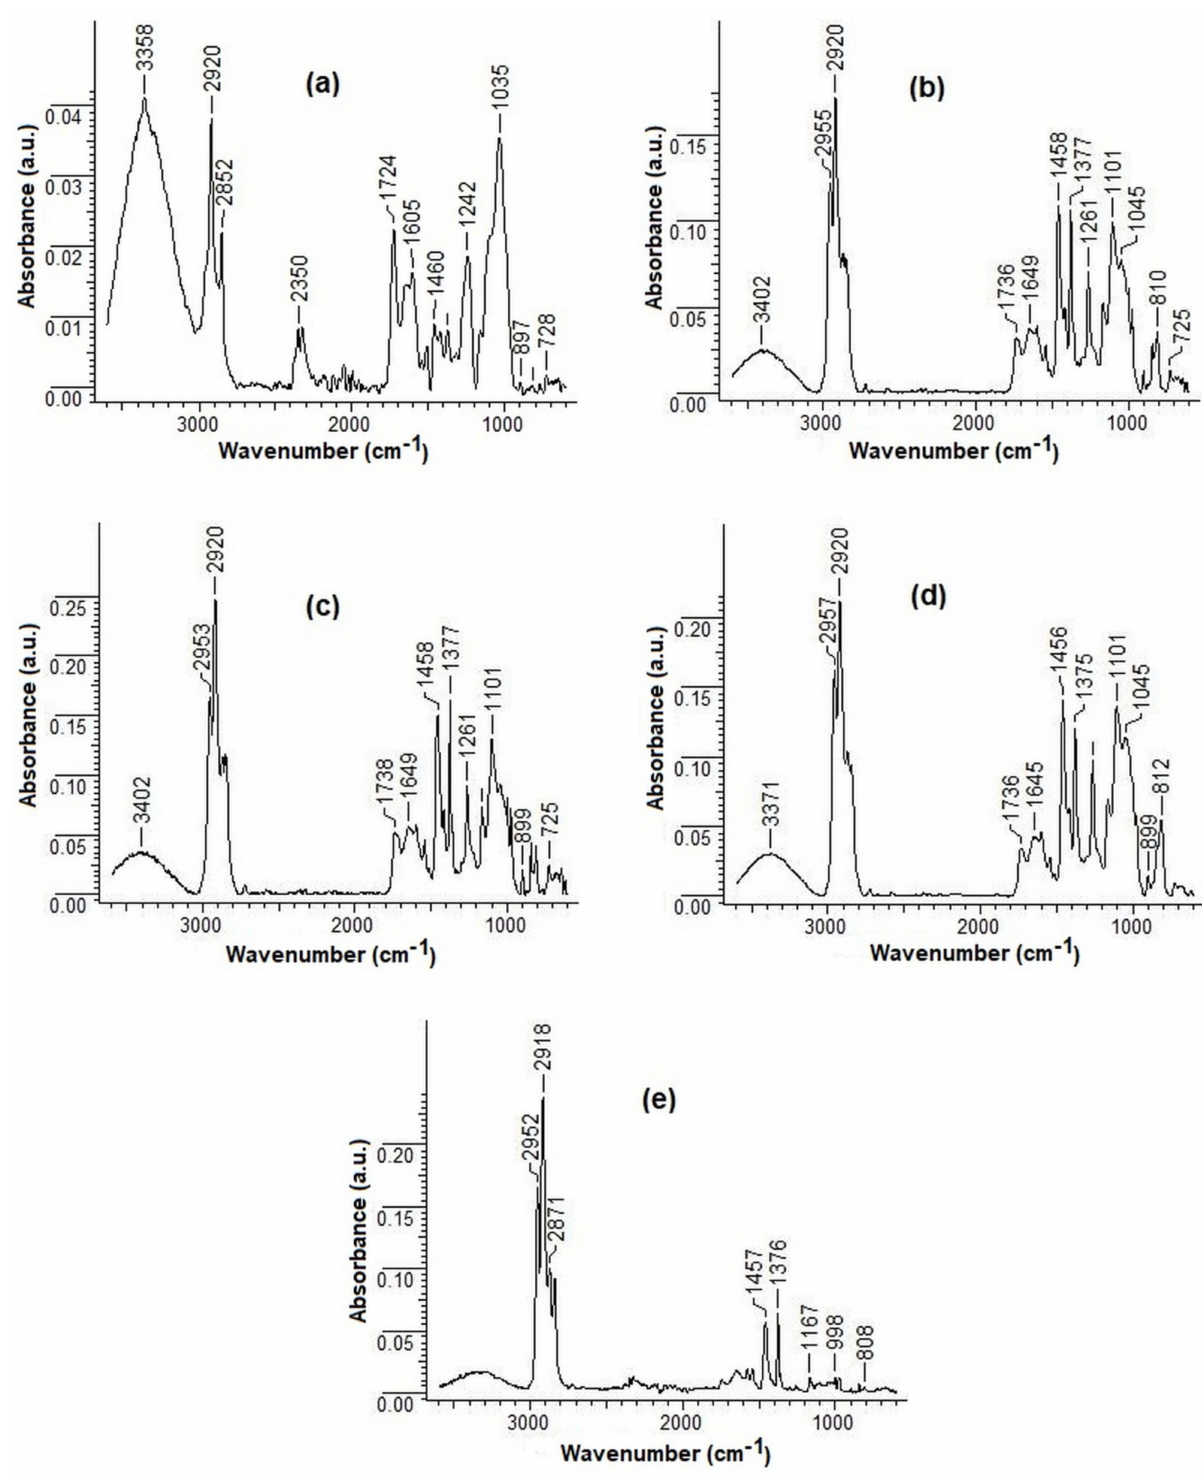
Figure 3. ATR-FTIR spectra of ( a ) 100Co; ( b ) 75Co25PP; ( c ) 50Co50PP; ( d ) 25Co75PP; and ( e ) 100PP. The wide band between 3402 cm − 1 and 3358 cm − 1 is characteristic to the